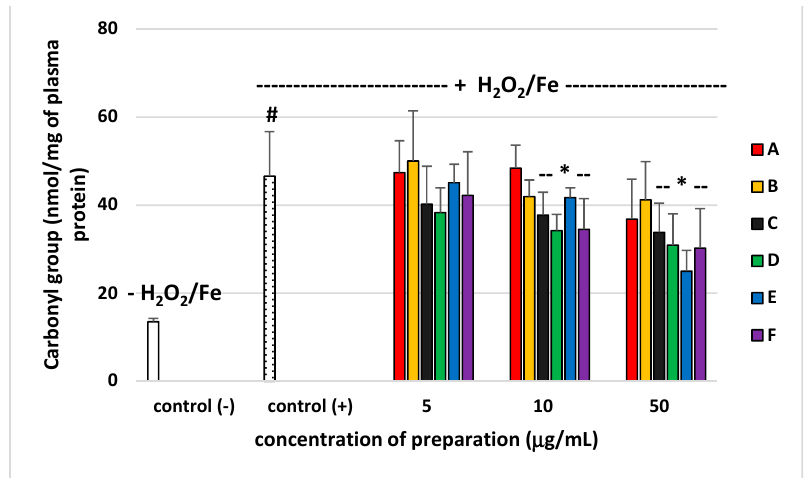
Figure 5. Effects of the preparations (A–F) of E. rhamnoides (L.) A. Nelson leaves and twigs (5–50 µg/mL; 30 min) on plasma protein carbonylation induced by H 2 O 2 /Fe. Data represent means ± SD of 6 independent experiments. * p < 0.05 ( vs . control (+)), # p < 0.01 ( vs . control (-)). Control negative (-) refers to plasma not treated with H 2 O 2 /Fe, whereas control positive (+) refers to plasma treated with H 2 O 2 /Fe.